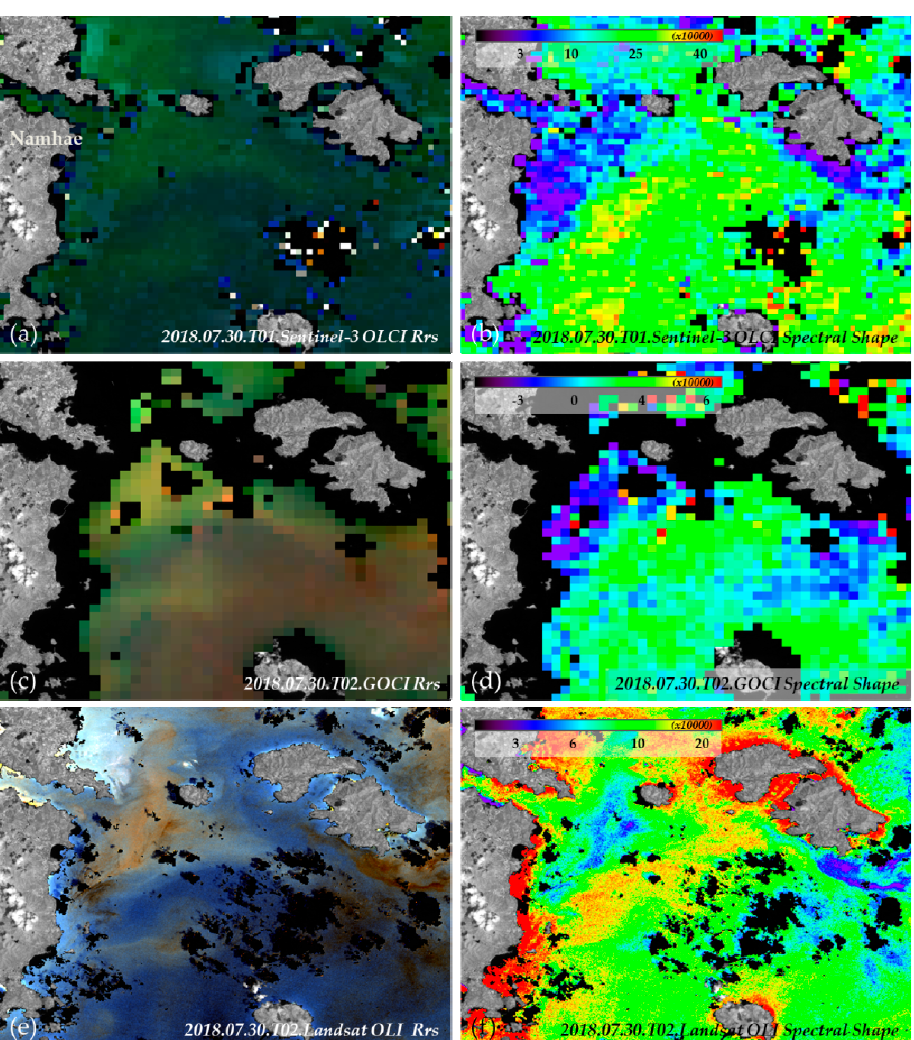
Figure 6. R rs true-color composite and Spectral Shape images collected by various sensors on 30 July 2018 at Namhae. ( a ) Sentinel-3 OLCI R rs true-color composite image (R: 681.25 nm; G: 560 nm; B: 442.5 nm), ( b ) Sentinel-3 OLCI Spectral Shape image, ( c ) GOCI R rs true-color composite image (R: 680 nm; G: 555 nm; B: 490 nm), ( d ) GOCI Spectral Shape image, ( e ) Landsat OLI R rs true-color composite image (R: 680 nm; G: 561 nm; B: 483 nm), ( f ) Landsat OLI Spectral Shape